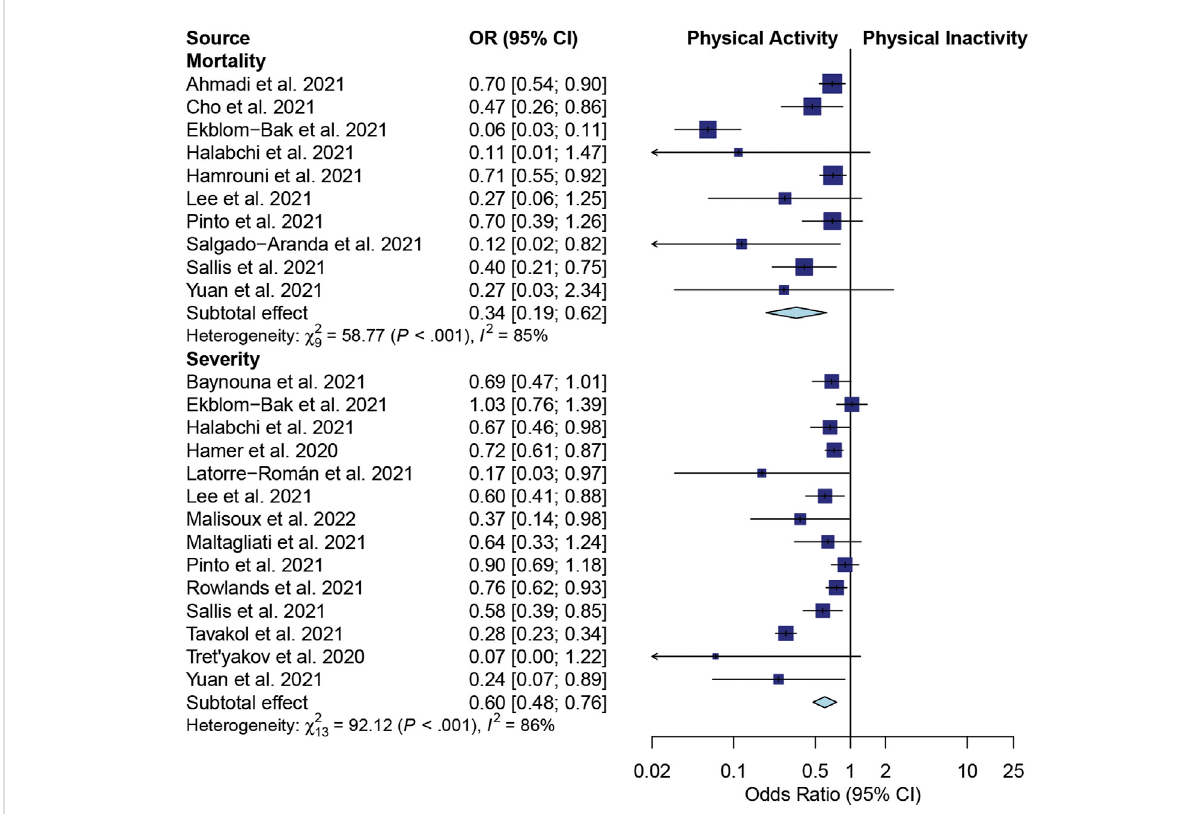
FIGURE 2 A forest plot of the association between physical activity and mortality and severity in COVID-19 patients.